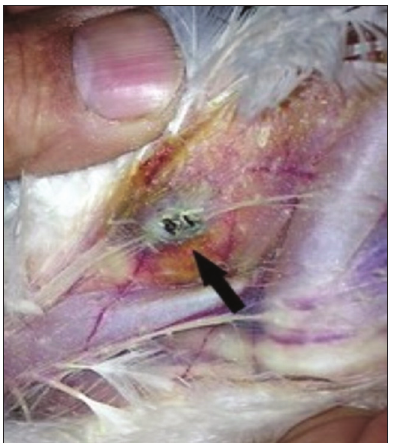
Figure-1: Pox vaccine “take” at 6-8 days post-vaccination in the avian encephalomyelitis + fowlpox + pigeon pox field vaccinated chickens.